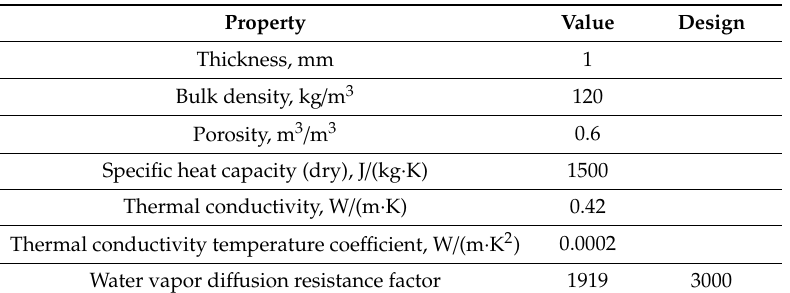
Table A22. Kraft paper property data.